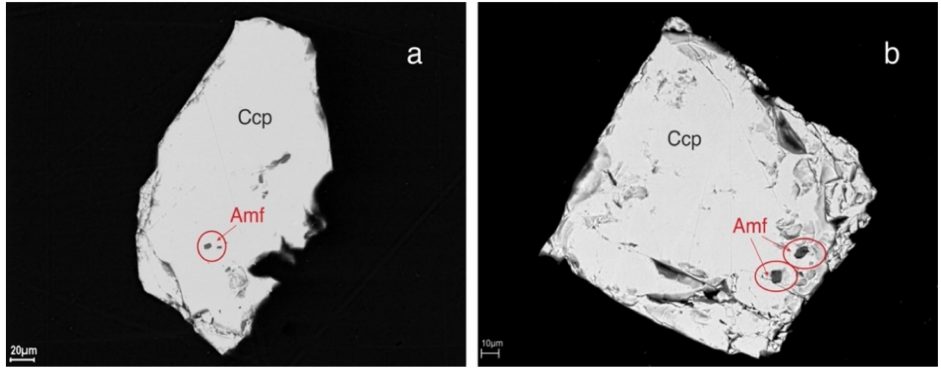
Figure 3. Silicate microinclusions (amphibole) in chalcopyrite from the Penikat intrusion ( a ) and the Fedorovo-Pansky complex ( b